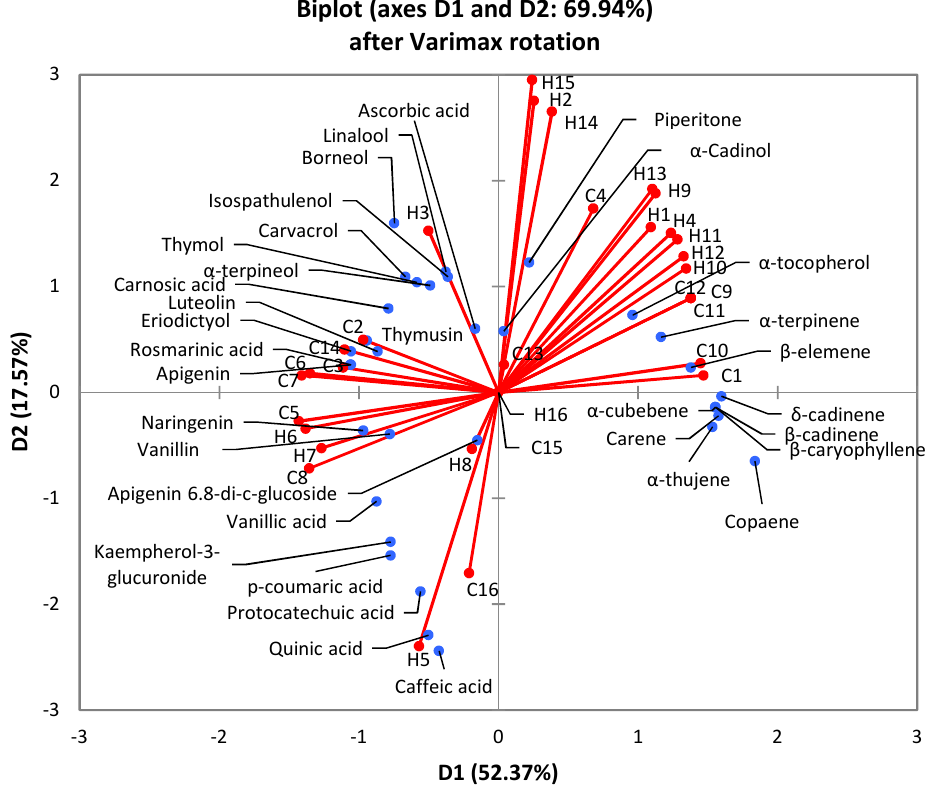
Figure 1. Biplot of the principal component analysis applied on data based on theoretical prediction models including (i) evaluated compounds (marked blue) and (ii) Hansen solubility parameters and COSMO-RS parameters (marked red). H-Hansen solubility parameters, C-COSMO-RS parameters, 1— n -hexane, 2—ethyl acetate, 3—methyl acetate, 4—ethyloleate, 5—ethanol, 6—1-butanol, 7—